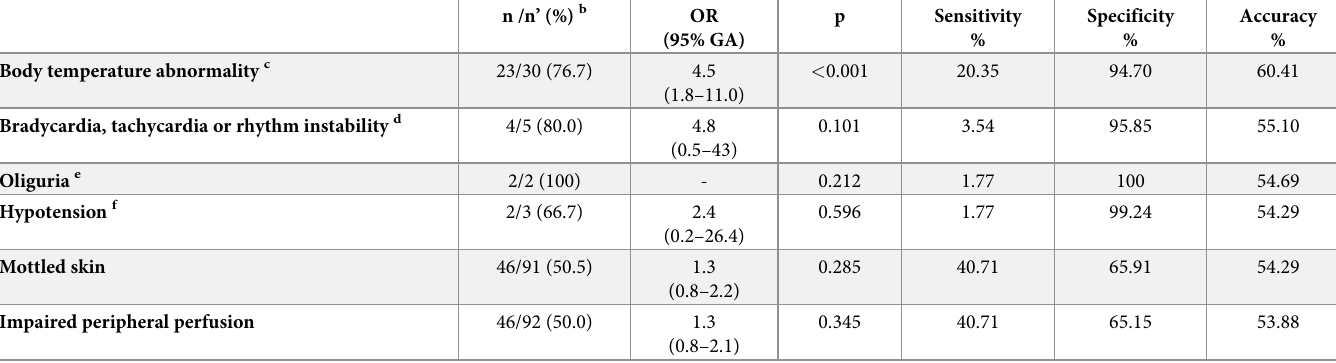
Table 2. Diagnostic accuracy measures of the clinical and laboratory findings included in the EMA sepsis criteria at the time of sepsis suspicion a